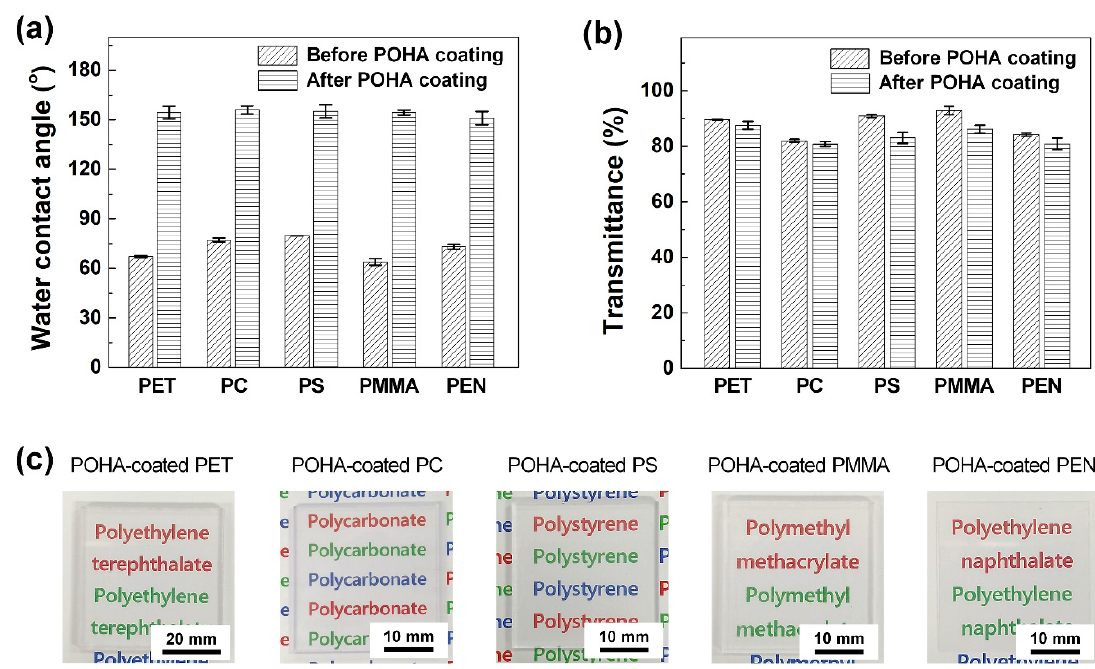
Figure 3. ( a ) WCAs and ( b ) transmittance of plastic substrates (PET, PC, PS, PMMA, and PEN) before/after POHA coating. ( c ) Photographs of five POHA-coated plastic substrates (PET, PC, PS, PMMA, and PEN). The colored letters printed on the paper under the plastic substrates are clearly visible.